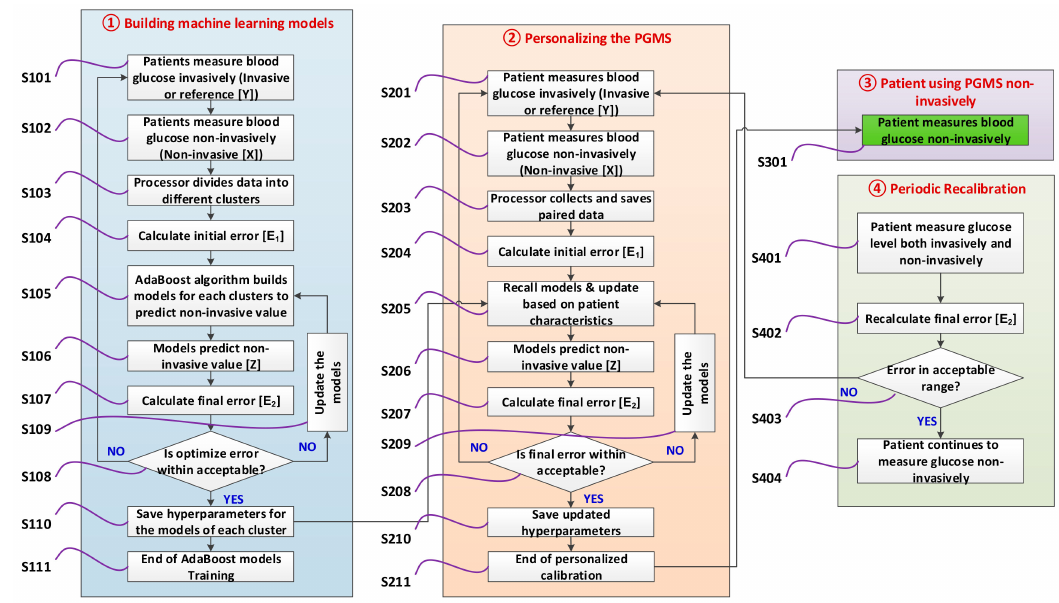
Figure 3. Software flowchart of the